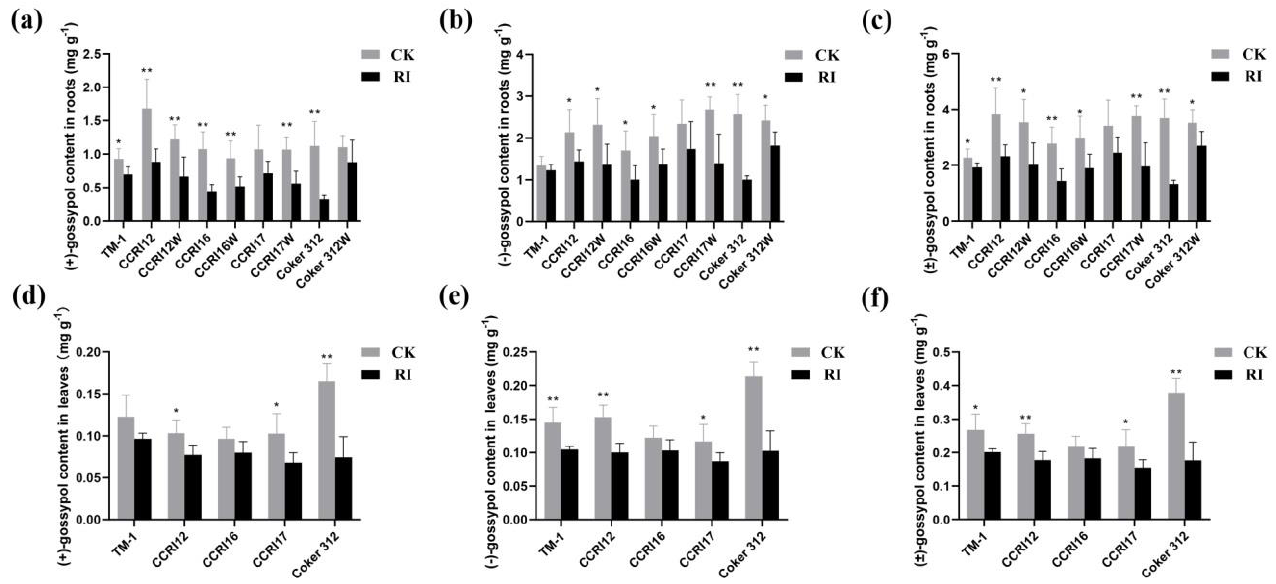
Figure 2. The effect of root illumination on the gossypol content in the glanded and glandless cotton seedlings. ( a – c ) the (+)-gossypol, ( − )-gossypol, and ( ± )-gossypol content of the roots in glanded and glandless cotton with and without root illumination (RI). ( d – f ) the (+)-gossypol, ( − )-gossypol, and ( ± )-gossypol content of the leaves in glanded and glandless cotton with and without RI. Error bars in figures represent standard deviation (SD) value ( n = 9), * indicate significance at p < 0.05, ** indicate significance at p < 0.01.